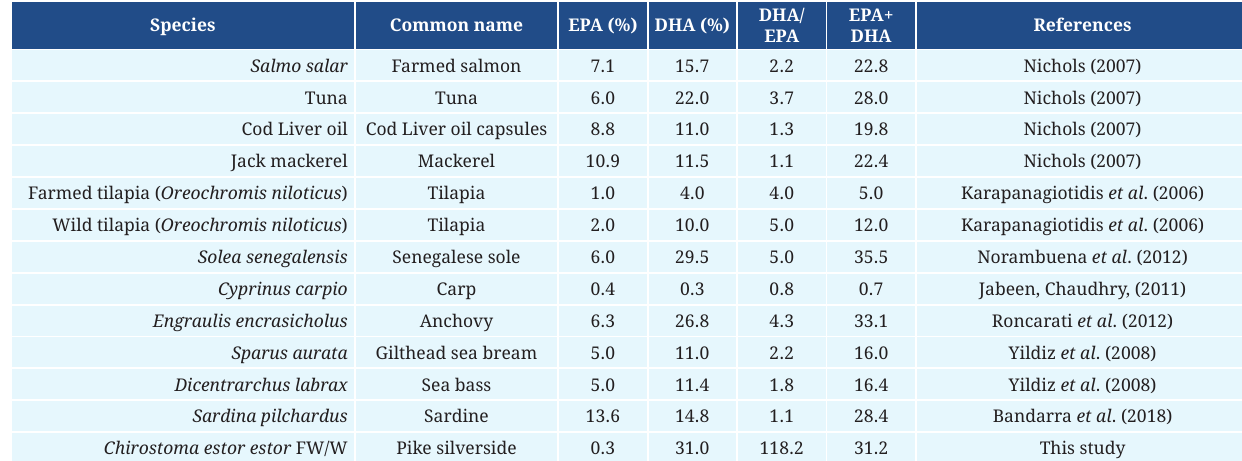
TABLE 2 | Long Chain Polyunsaturated Fatty Acids (LC-PUFA) content in the muscle of common fish species and supplements for human consumption. Freshwater (FW), Wild